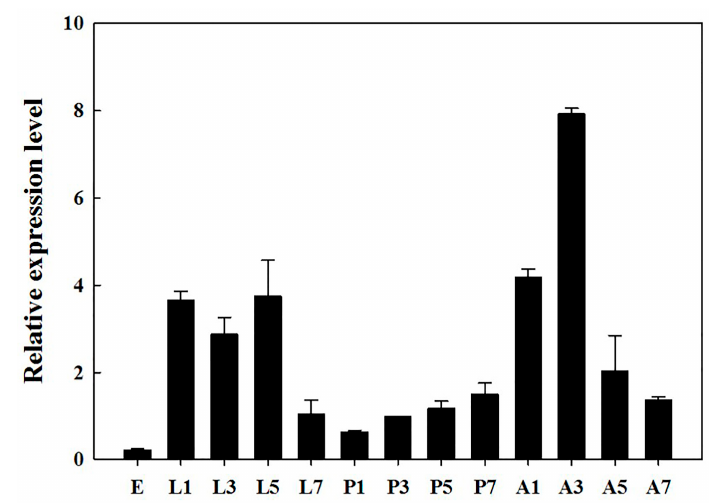
Figure 3. Relative expression levels of BdOct β R1 at different developmental stages. Different stages are displayed by E (egg), L (larva), P (pupa), and A (adult). Different numbers 1, 3, 5, 7 represent days 1, 3, 5, and 7 of the developmental stage, respectively. The data shown are mean ± standard error (S.E.) ( n = 3), normalized relative to α -tubulin transcript levels.